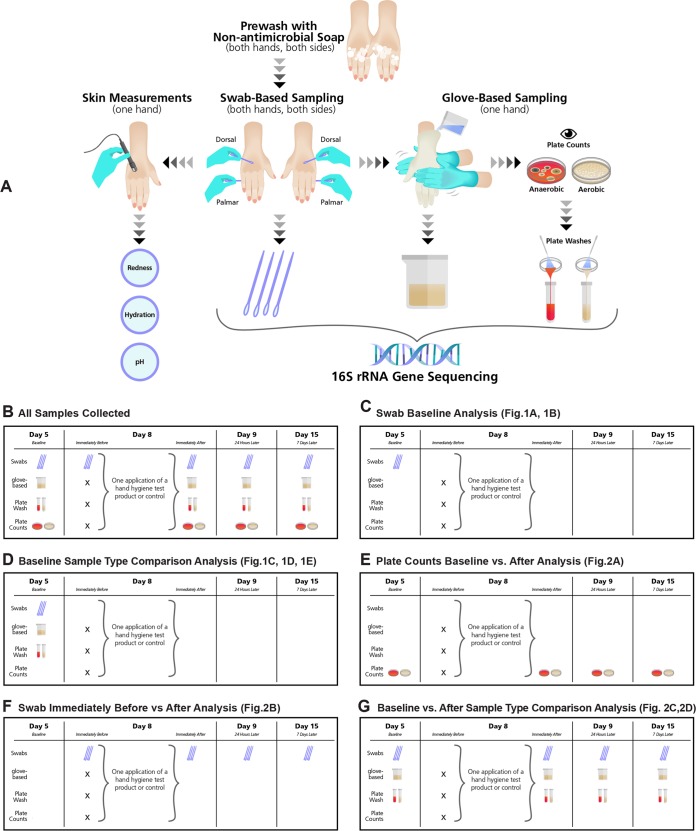
Study methodology. (A) Hand samples and measurements taken are visualized. First, hands were prewashed to remove transient microorganisms. Next, swab samples were taken on both sides of both hands, and then skin measurements were taken from one hand on the dorsal side, while the other hand was sampled using the glove-based method. A portion of each glove-based sample was directly sequenced, and another portion was plated aerobically and anaerobically. Colonies were counted, the growth from the plates was collected, and the plate washes were sequenced. (B) On study days 5, 9, and 15, all sample types were collected. On day 8, only swab samples were collected immediately before hygiene treatment, and all sample types were collected after treatment. Illustrations of which samples were used in the various comparative analyses among sample types collected on different days of the study are shown in panels C to G.